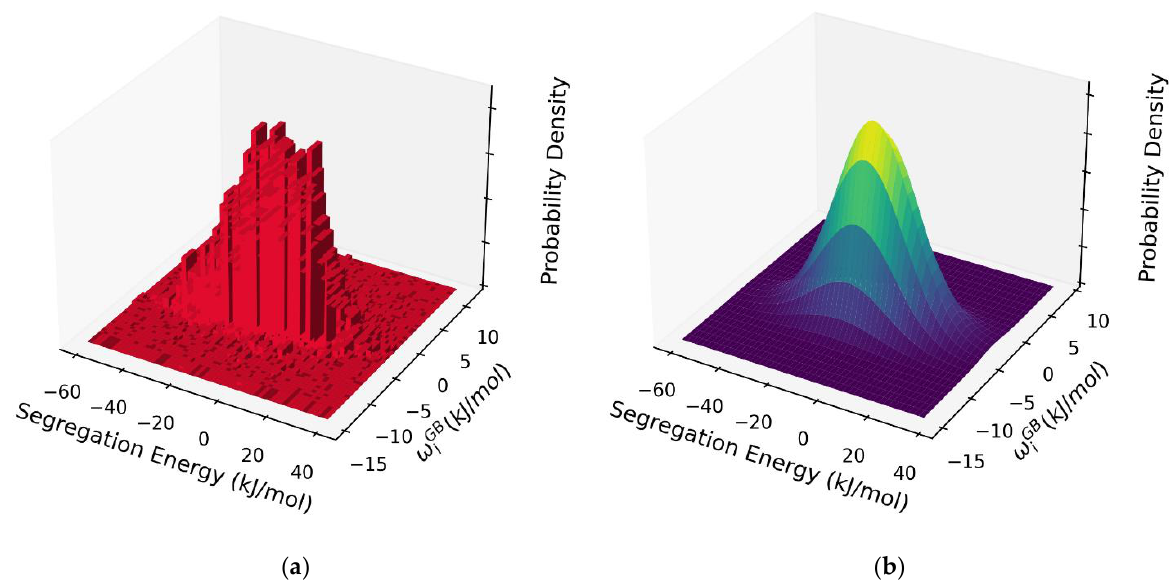
Figure 7. ( a ) 2D histogram of the dilute limit segregation energy and per-site interaction parameter ѡ 𝑖𝐺𝐵 , exhibiting a bivariate skew-normal distribution. ( b ) Bivariate normal distribution fitted to the data depicted in Figure 7a.